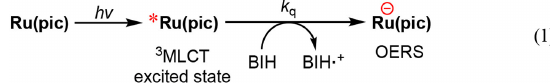
of the 3 MLCT excited state of Ru(pic) by BIH proceeded successfully to give OERS of Ru(pic) (Equation 1) and Ru(pic) can be expected to function as a redox photosensitizer over the wide-range absorption of visible